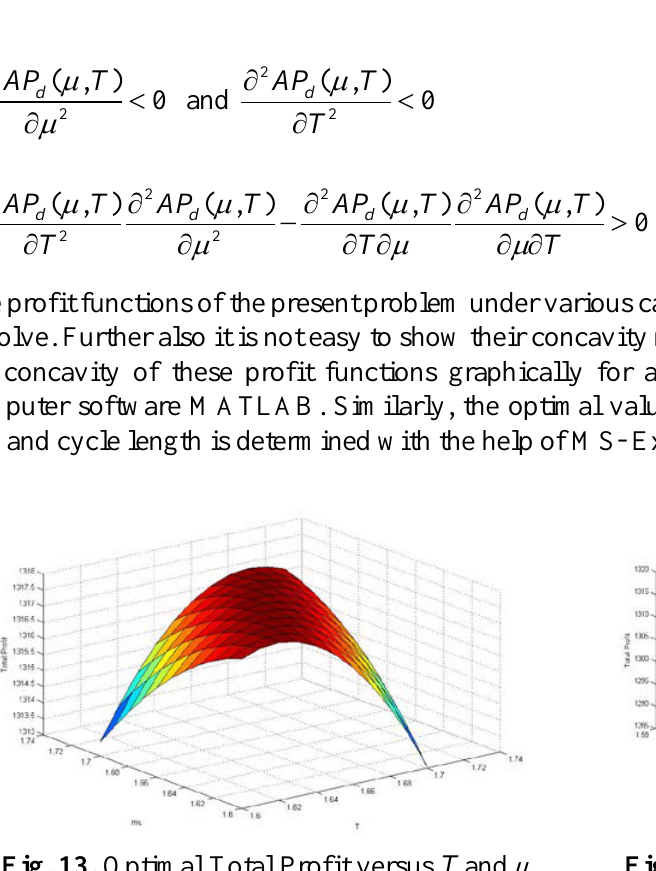
Fig. 13. Optimal Total Profit versus T and μ Fig. 14. Optimal Total Profit versus T and